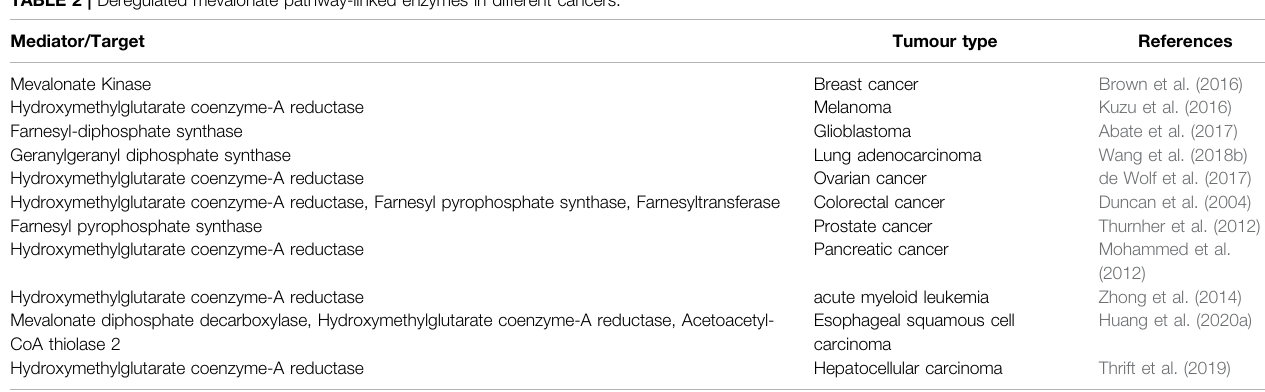
TABLE 2 | Deregulated mevalonate pathway-linked enzymes in different